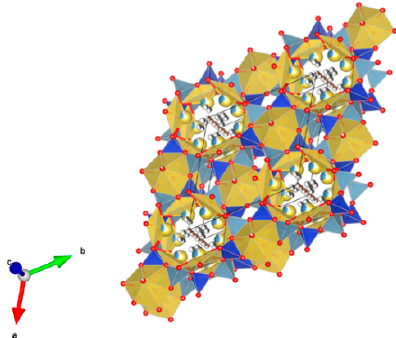
Figure 20. Cancrinite. (Na,Ca,K) 6 [Al 6 Si 6 O 24 ]((Na,Ca,K) 2 CO 3 ) 1.6 ·2.1H 2 O. Structure hexagonal,